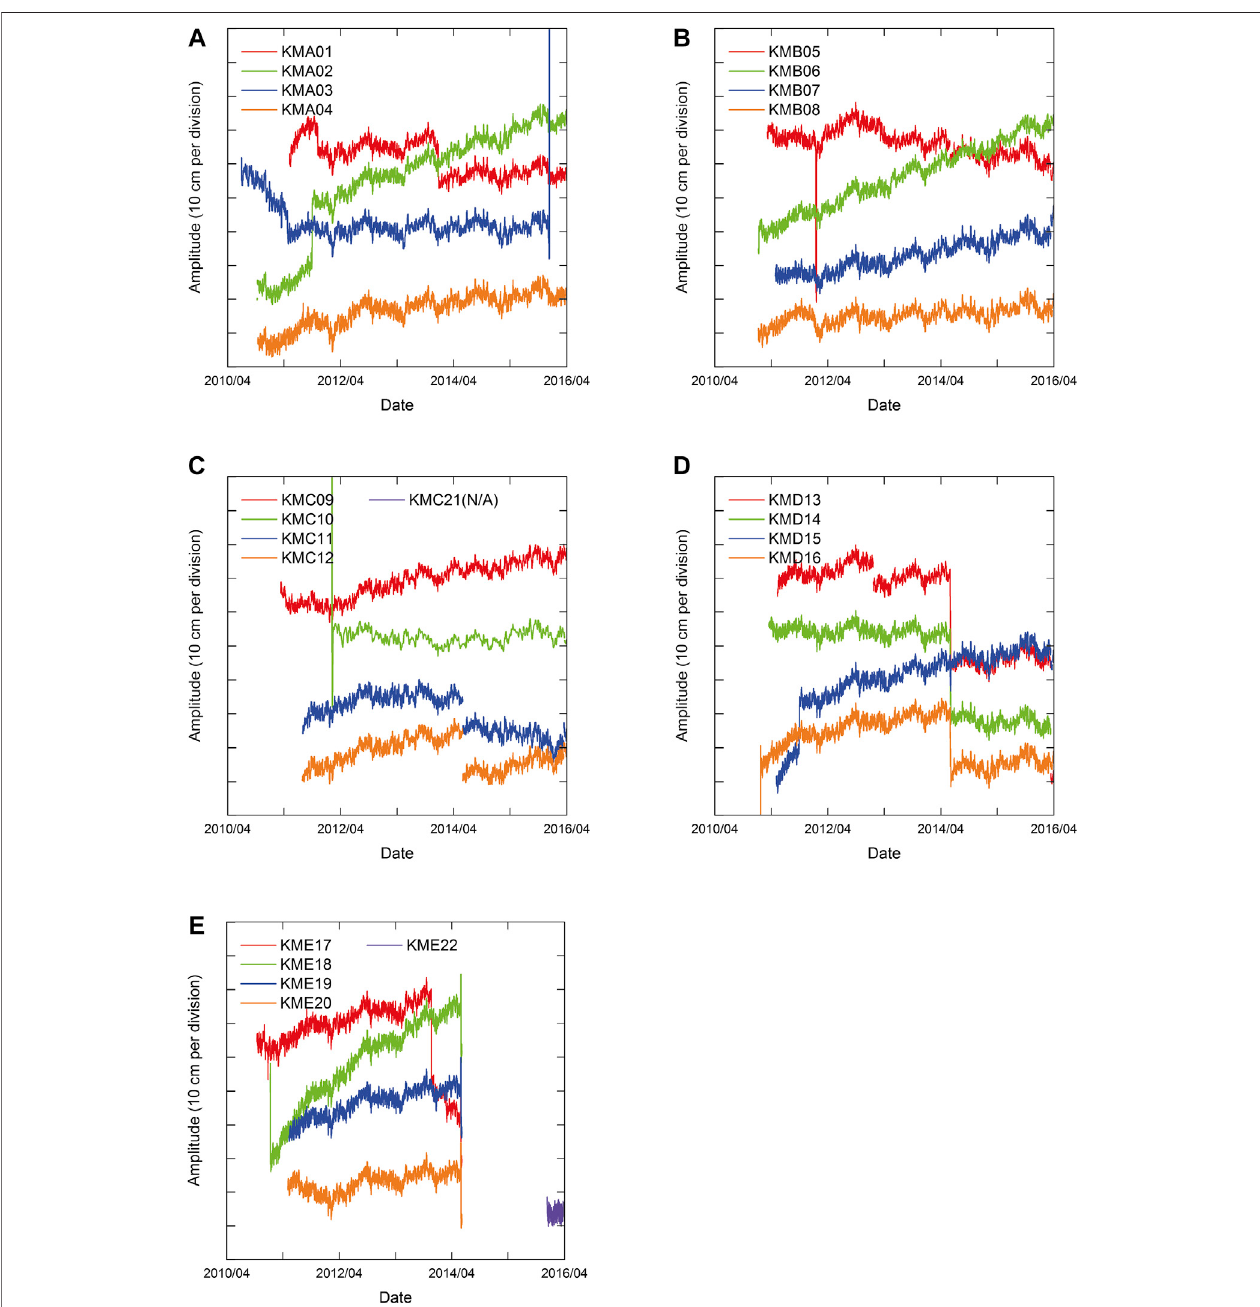
FIGURE 4 | (A) Trend component of pressure sensors analyzed by Baytap08 of KMA observatories. Each tick on the vertical axis represents 10 cm water depth change. (B) KMB, (C) KMC, (D) KMD, and (E) KME observatories are presented in the same form as (A) .